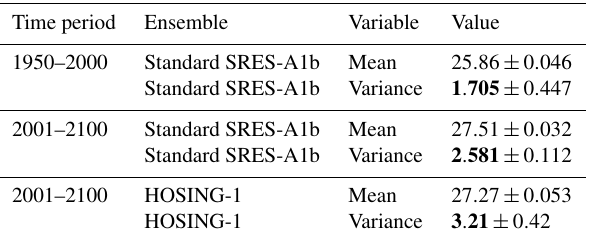
Figure 6. (a) Evolution of the five standard SRES-A1b runs (black) and five HOSING-1 runs (red) in terms of the overturning stream function. (b) NINO3.4 of the standard SRES-A1b ensemble (black) and the HOSING-1 ensemble (red). Shaded thin lines indicate monthly means, thick lines indicate the deseasonalised values. Table 5. NINO3.4 statistics (of deseasonalised data) for the dif- ferent ensembles. The uncertainty stated is the standard deviation among the five runs within the ensemble. It is visible that in the case of a collapsed overturning, El Niño intensifies more than with- out a collapsed overturning. Values in bold represent increases in the variability of